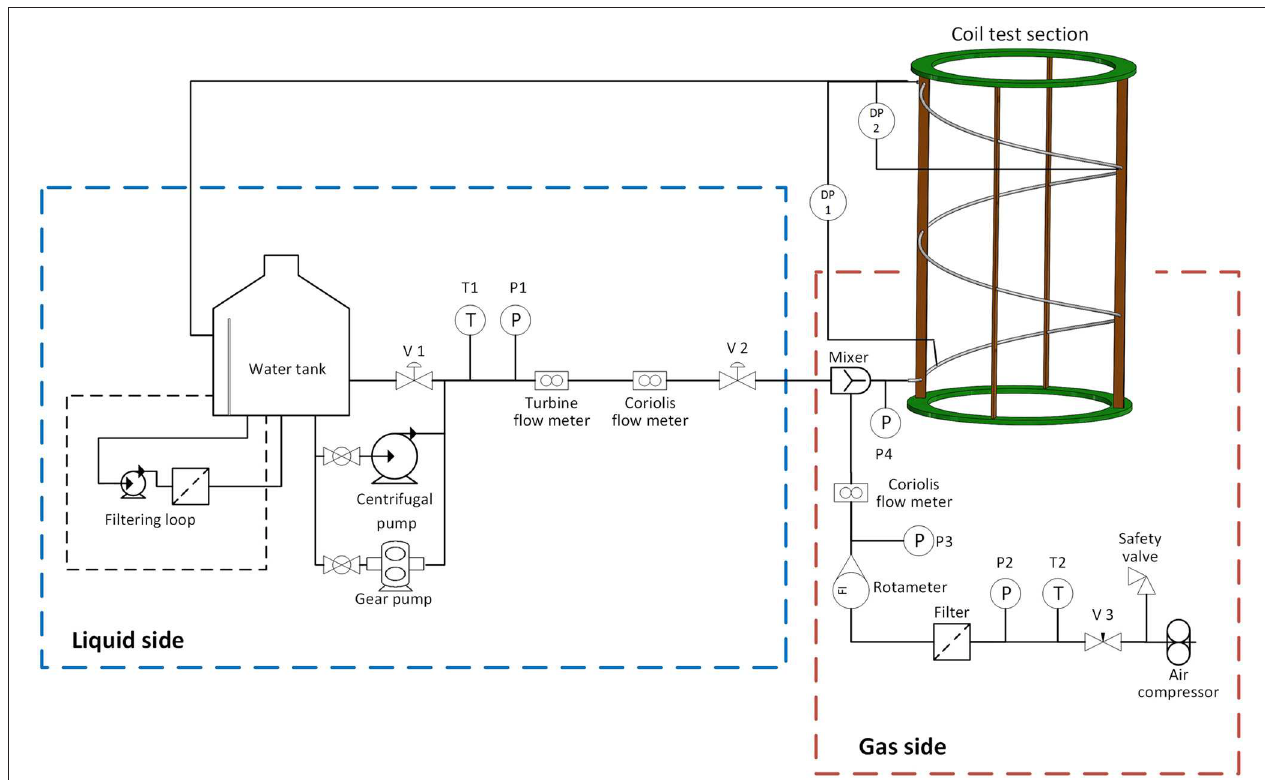
FIGURE 1 | Scheme of the experimental facility.